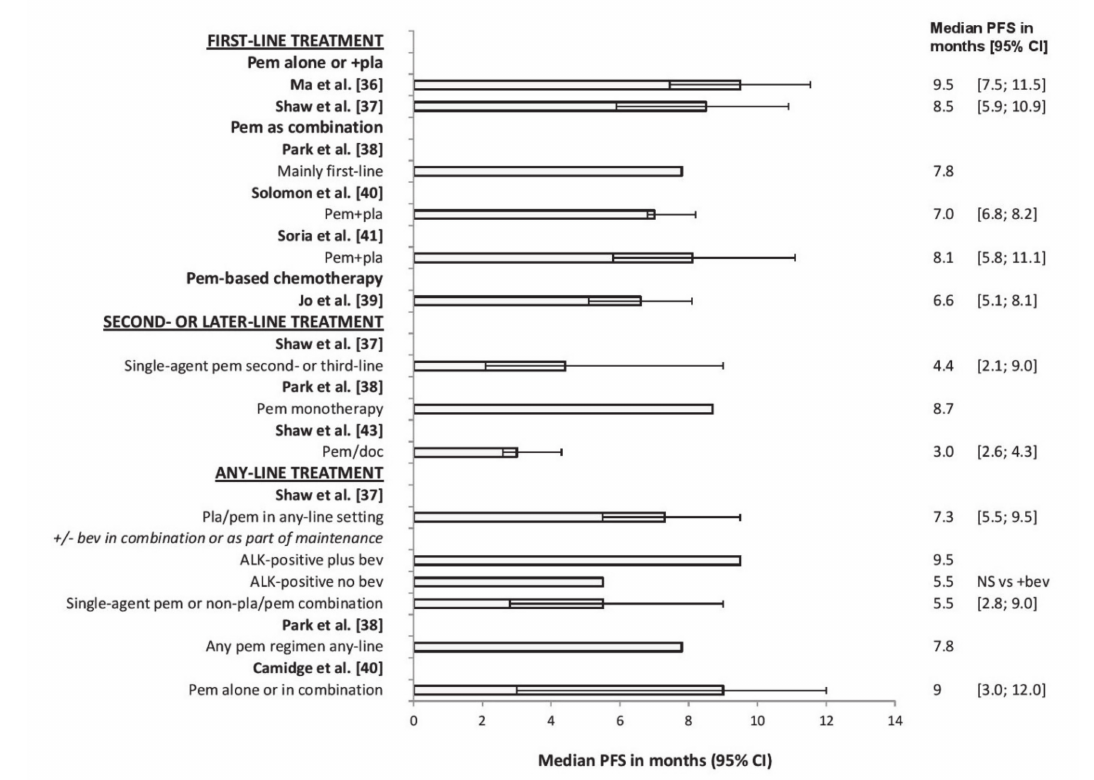
Figure 2. Median PFS with pemetrexed-based treatment in patients with advanced nonsquamous NSCLC and ALK rearrangements. Abbreviations: anaplastic lymphoma kinase (ALK); bevacizumab (bev); carboplatin (car); cisplatin (cis); confidence interval (CI); non-small-cell lung cancer (NSCLC); not significant (NS); pemetrexed (pem); progression-free survival (PFS); placebo (PL); platinum (pla); docetaxel (doc); hazard ratio